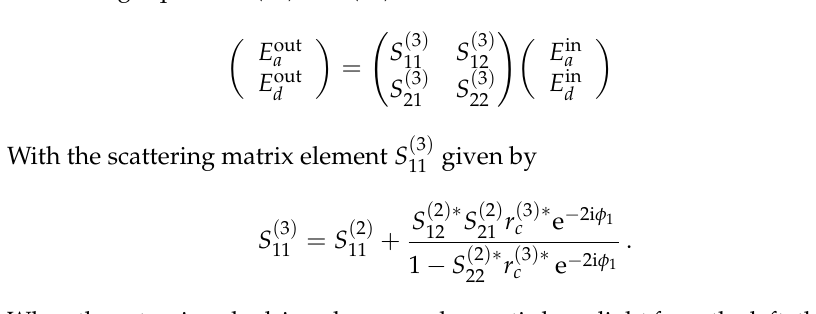
and E out with i = a , b , c , d near the relevant i i